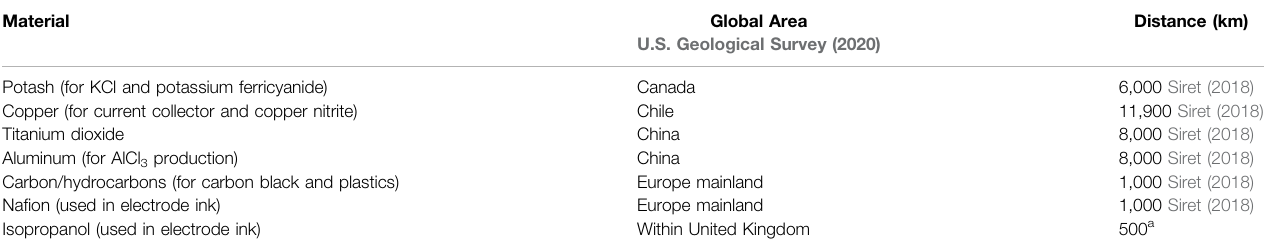
Potash (for KCl and potassium